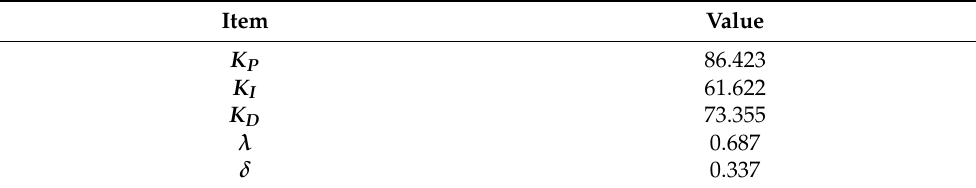
Table 8. Optimal values of the FOPID-PODC parameters for Scenario 2.